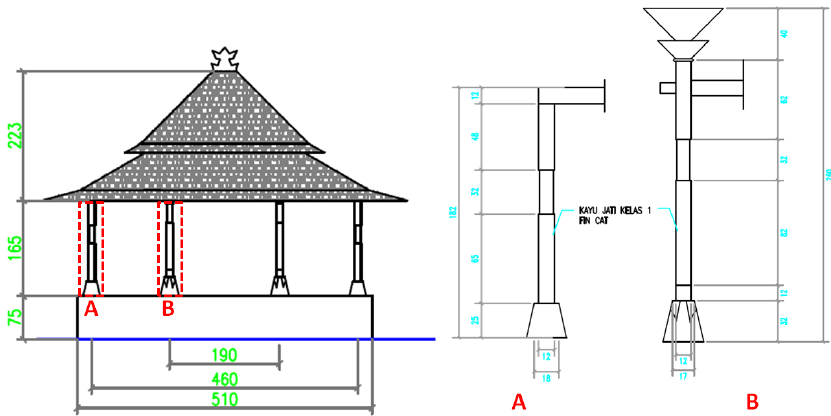
Figure 2. An excerpt of the architectural drawings for the Central Pavilion of Siti Inggil commissioned by the Tourism and Cultural Service of the Province of West Java. Note the two-dimensional nature of the drawings, which shows only measurements for one facade, while assuming that all of the object’s sides are